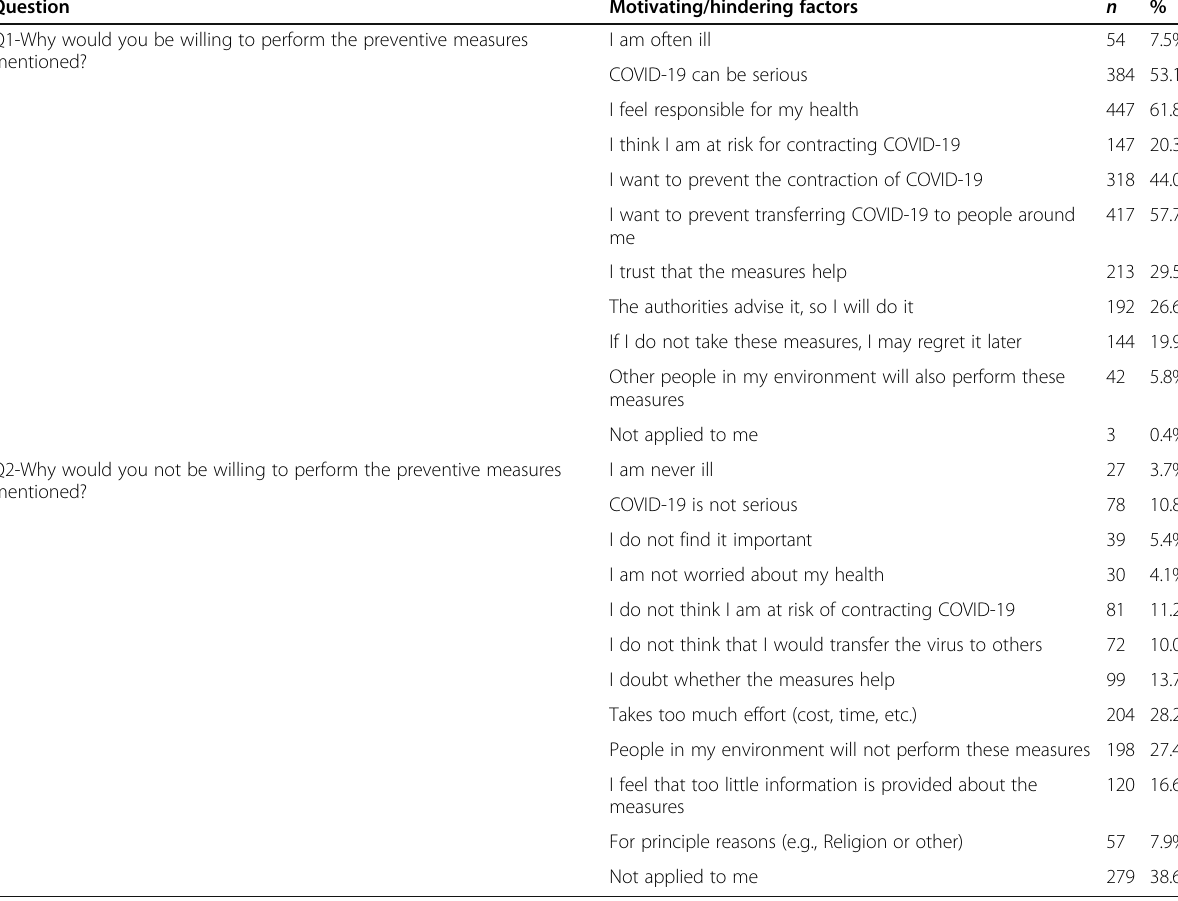
Table 13 Assessment of the motivating and hindering factors that affect compliance with preventive measures ( N = 723) Question Motivating/hindering factors